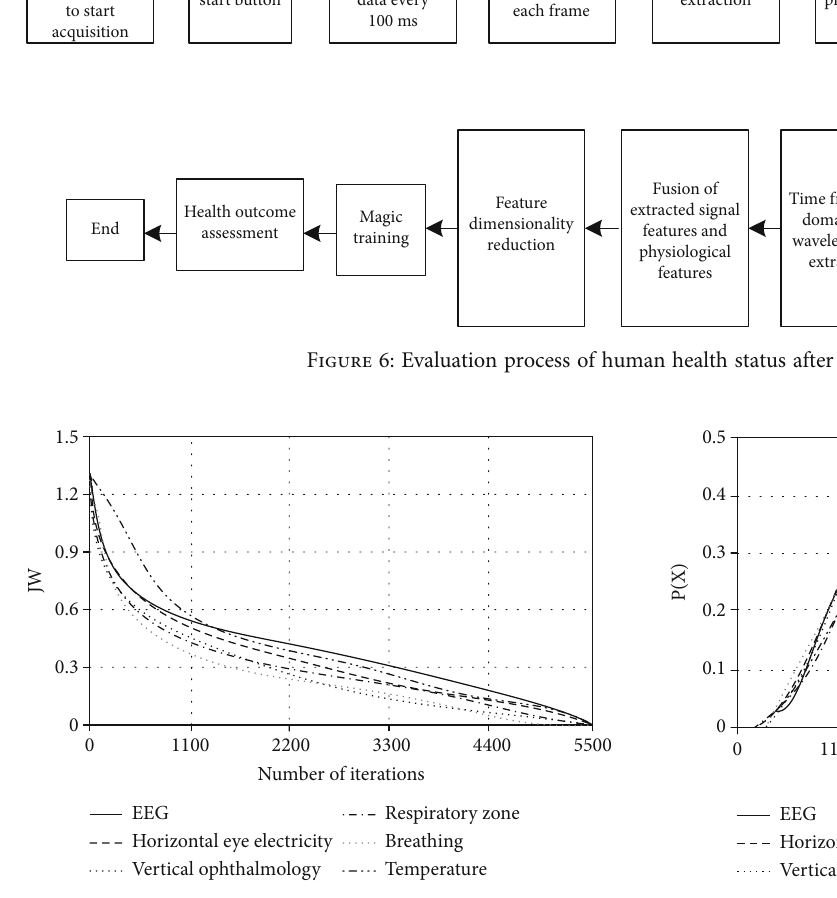
Figure 7: Curve relationship between iteration times and JW.